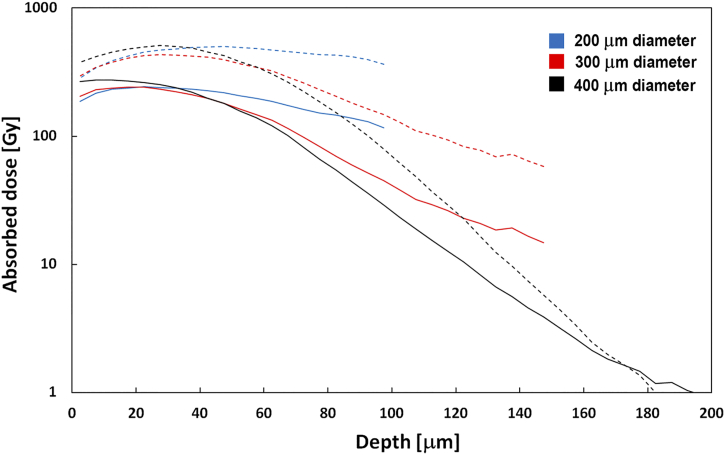
Modeled absorbed dose profiles of assumed spherical microscopic tumors of various diameters exposed to intraperitoneally administered 211At-farletuzumab. Dashed lines indicate modeled results for microtumors in mice exposed to amounts presented in the current work. Solid lines are model results for microtumors in patients exposed to clinically relevant amounts.